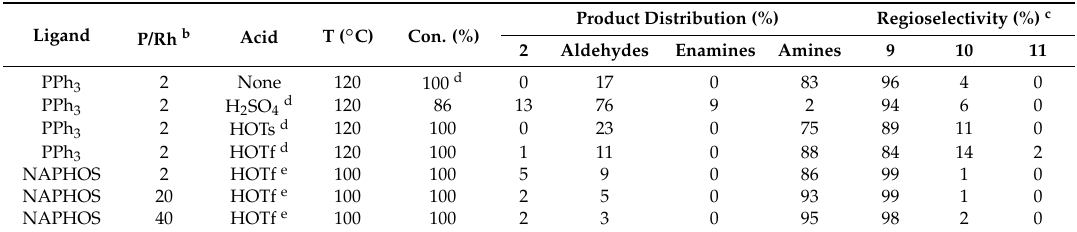
Table 2. Hydroaminomethylation of eugenol ( 1 , Figure 14) with di- n -butylamine: effect of added acid a . Adapted from [79].